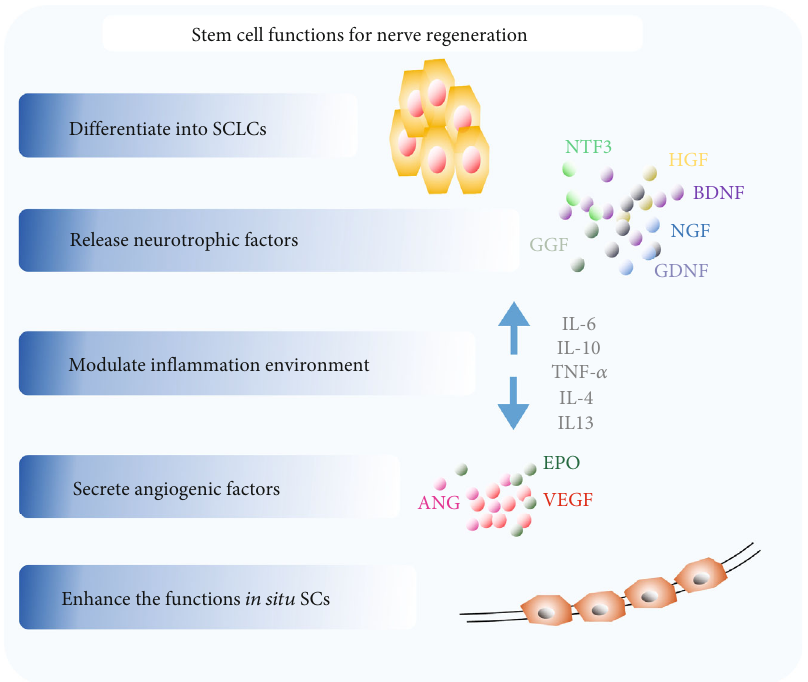
Figure 1: Adult stem cell types.